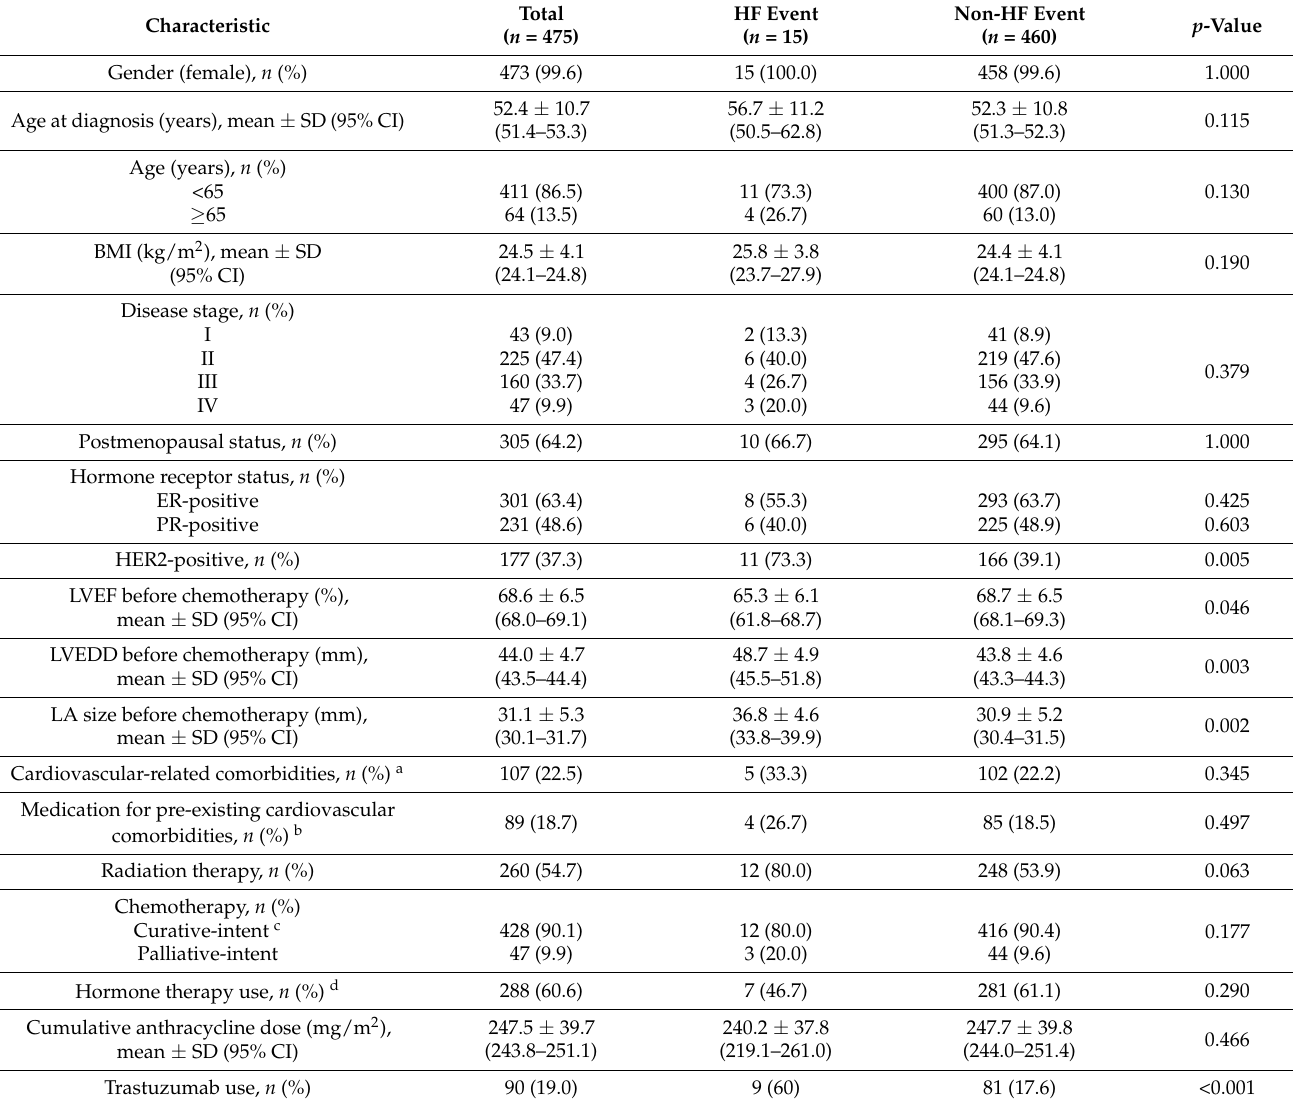
Table 1. Baseline and treatment characteristics ( n =